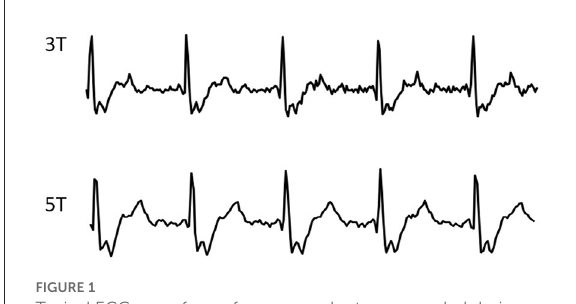
FIGURE1 Typical ECG wave forms from one volunteer, recorded during CMR CINE scans at 3 and 5T respectively.